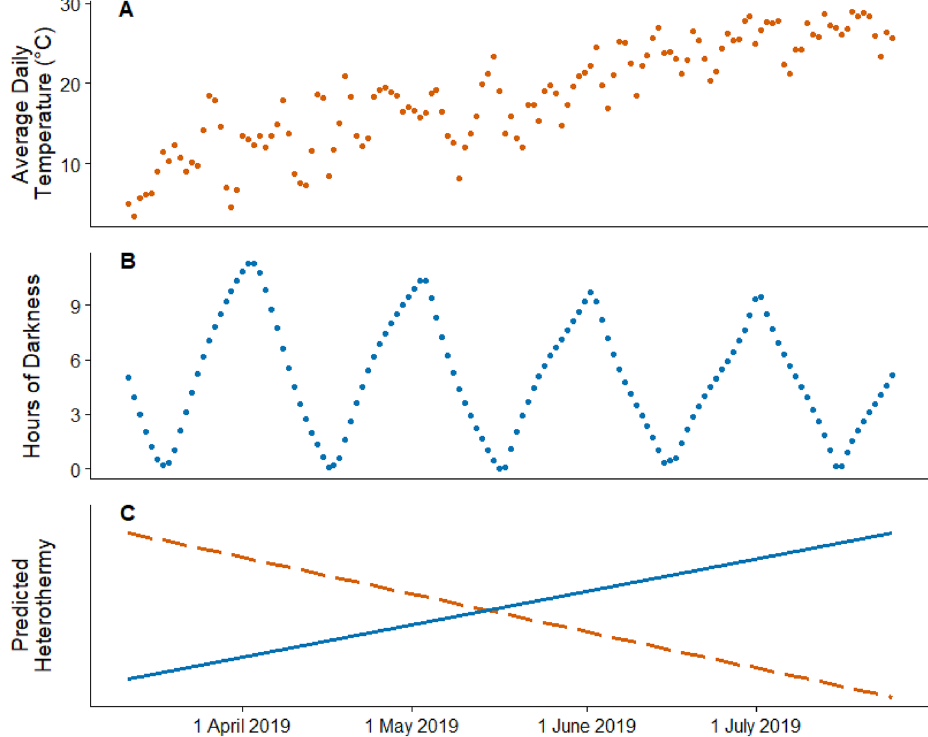
Figure 1. Both environmental temperatures and activity affect thermoregulation in endotherms, though in potentially contrasting ways. Activity in nocturnal desert rodents is known to be strongly correlated to the lunar cycle, as rodents forage most intensely during periods when the moon is below the horizon and visual predators are less effective. The opposing trends in temperature and hours of darkness across the study period allow us